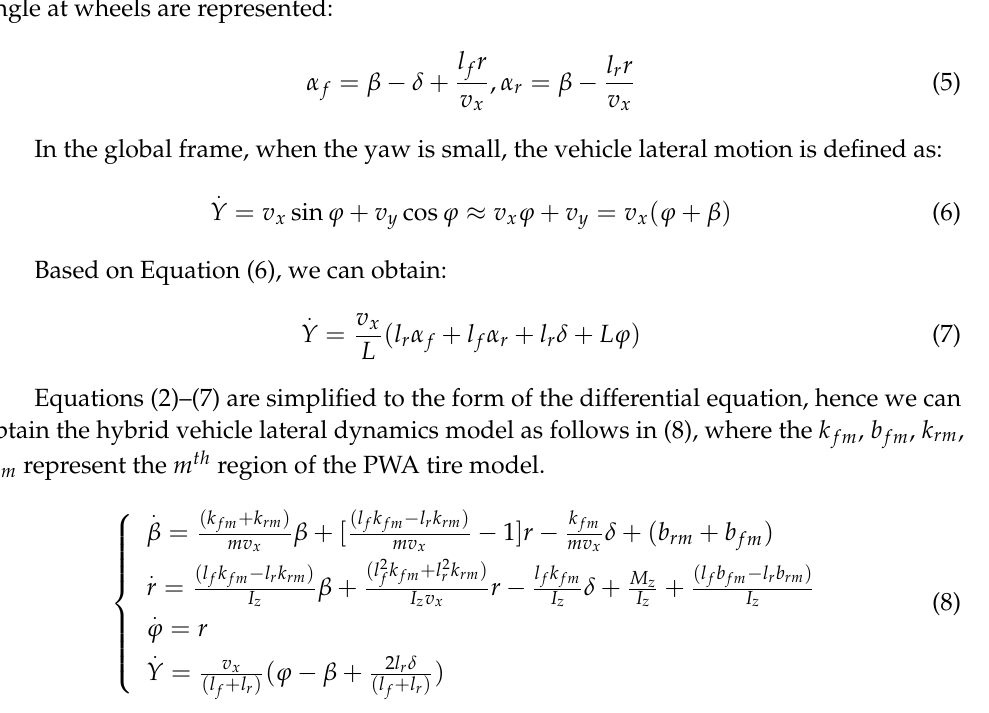
v β= , so the sideslip / y